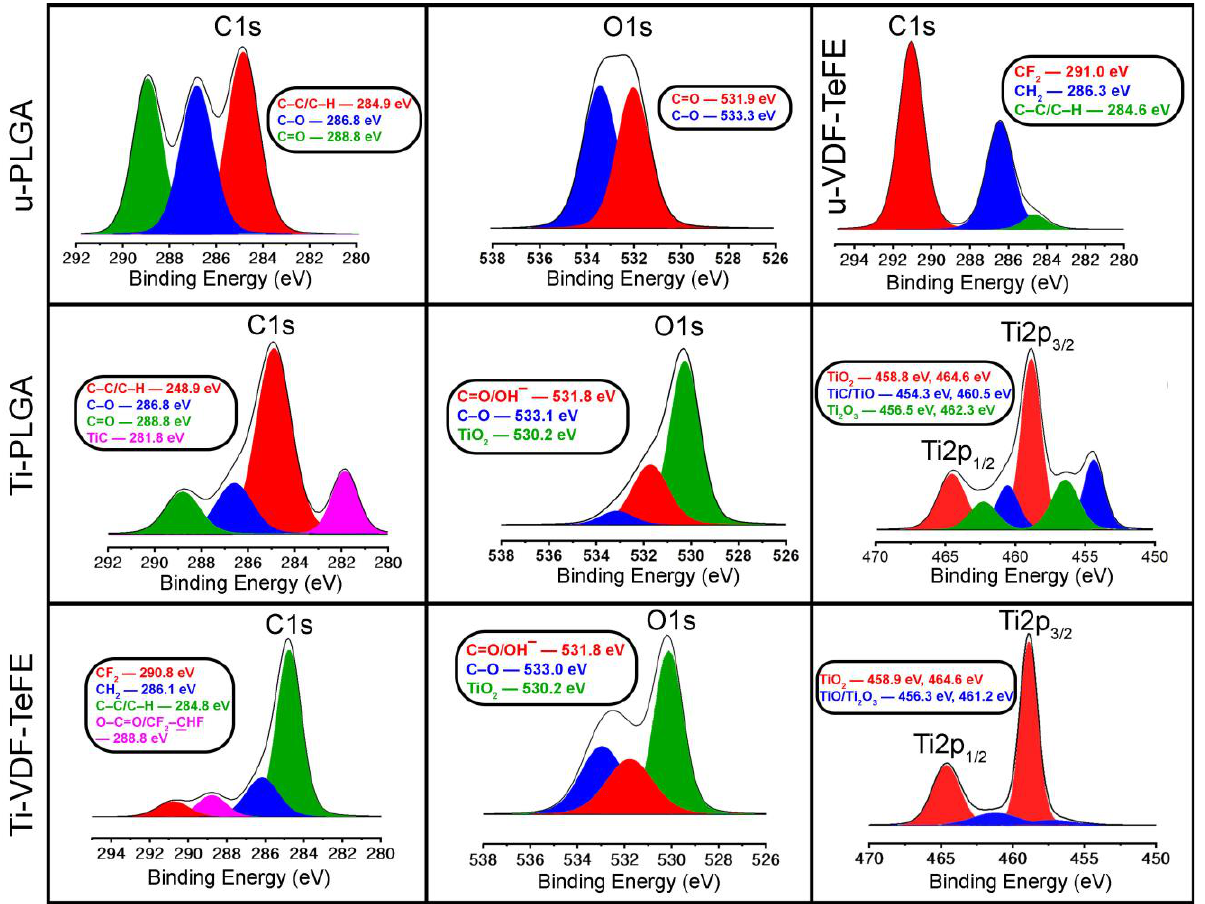
Figure 3. The C1s, O1s and Ti2p XPS spectra of u-PLGA, u-VDF-TeFE, Ti-PLGA and Ti-VDF-TeFE scaffolds. The u-PLGA and u-VDF-TeFE scaffold samples have no corresponding XPS spectra due to the lack of some elements in the polymer surfaces (O1s for the u-VDF-TeFE scaffold and Ti2p for both unmodified scaffolds).